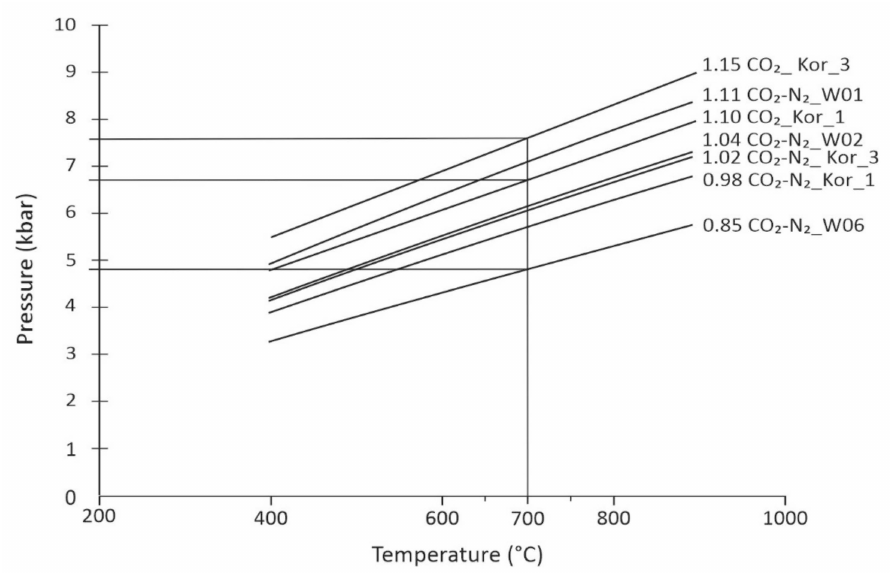
Figure 7. P-T diagram containing FI density isochores from selected high-density FIs of the studied garnet samples. Isochores are cut by a temperature of 700 ◦ C, taken from the literature. Numbers correspond to FIs of highest densities in g/cm 3 (see text for